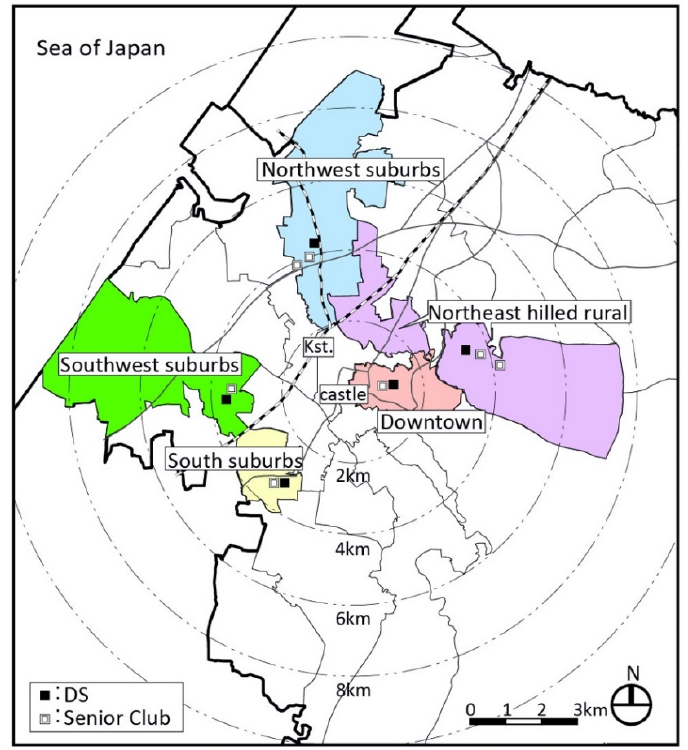
Figure 3. Five target districts in Kanazawa (unit: kilometers). Kaga has an urban structure with multiple urban cores of old towns (Figure 4). There are two secondary medical institutions (hospitals) in the center of the old city and one in the former Yamanaka town (middle mountainous hot spring town district). There